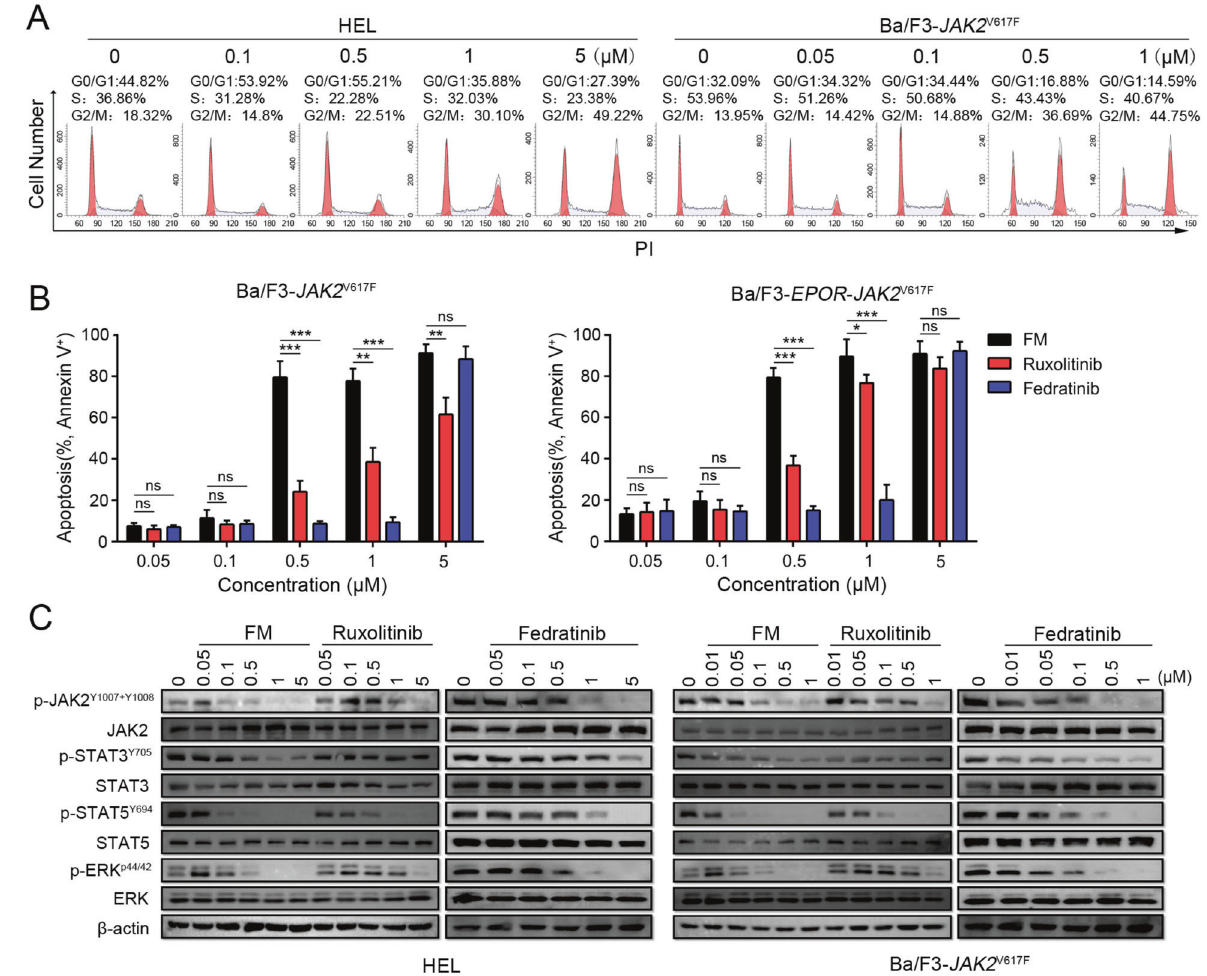
Fig. 2 Inhibition of JAK2 -dependent cell lines via FM in vitro. A HEL and Ba/F3- JAK2 V617F cells were supplemented with different concentrations of FM for 24 h, and the cell cycle was analyzed via propidium iodide (PI) staining. B Ba/F3- JAK2 V617F and Ba/F3- EPOR - JAK2 V617F cells were treated for 48 h with FM and analyzed by Annexin V and PI co-staining. Data are represented as mean ± SD, * p < 0.05, ** p < 0.01, *** p < 0.001 vs. FM, t -test. C Effect of 3 h incubation with FM, ruxolitinib (Ruxo), and fedratinib (Fedra) on phosphorylation of JAK2, STAT3, STAT5, and ERK in HEL and Ba/F3- JAK2 V617F cell lines. β -actin served as the loading